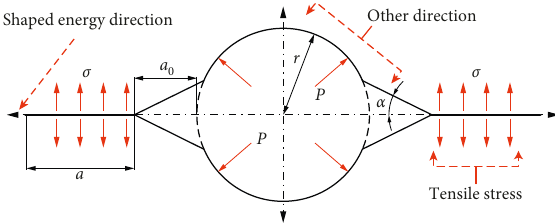
Figure 5: Fracture mechanics model of cumulative tensile